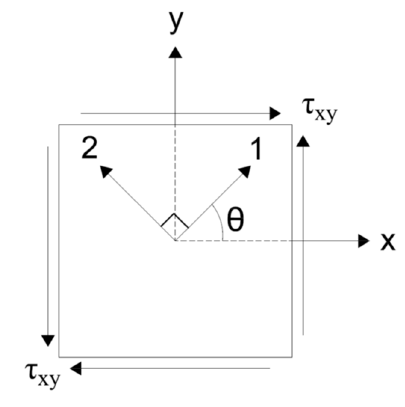
Figure 5. Element subjected to pure shear.